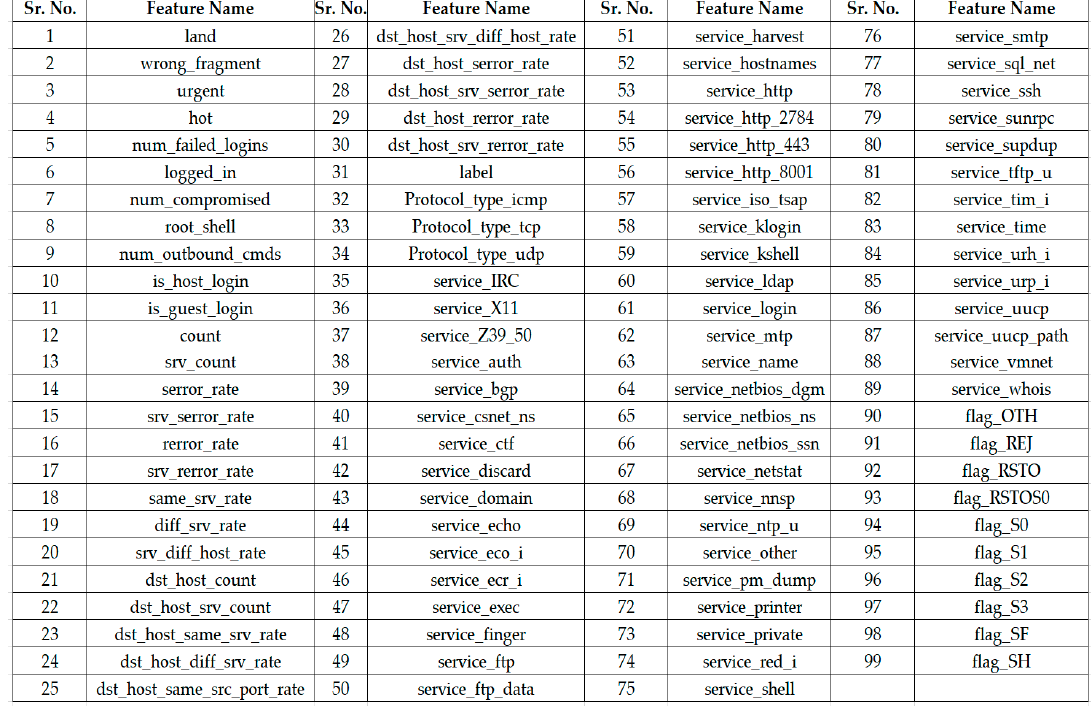
Figure 5. Features set after applying the GA.